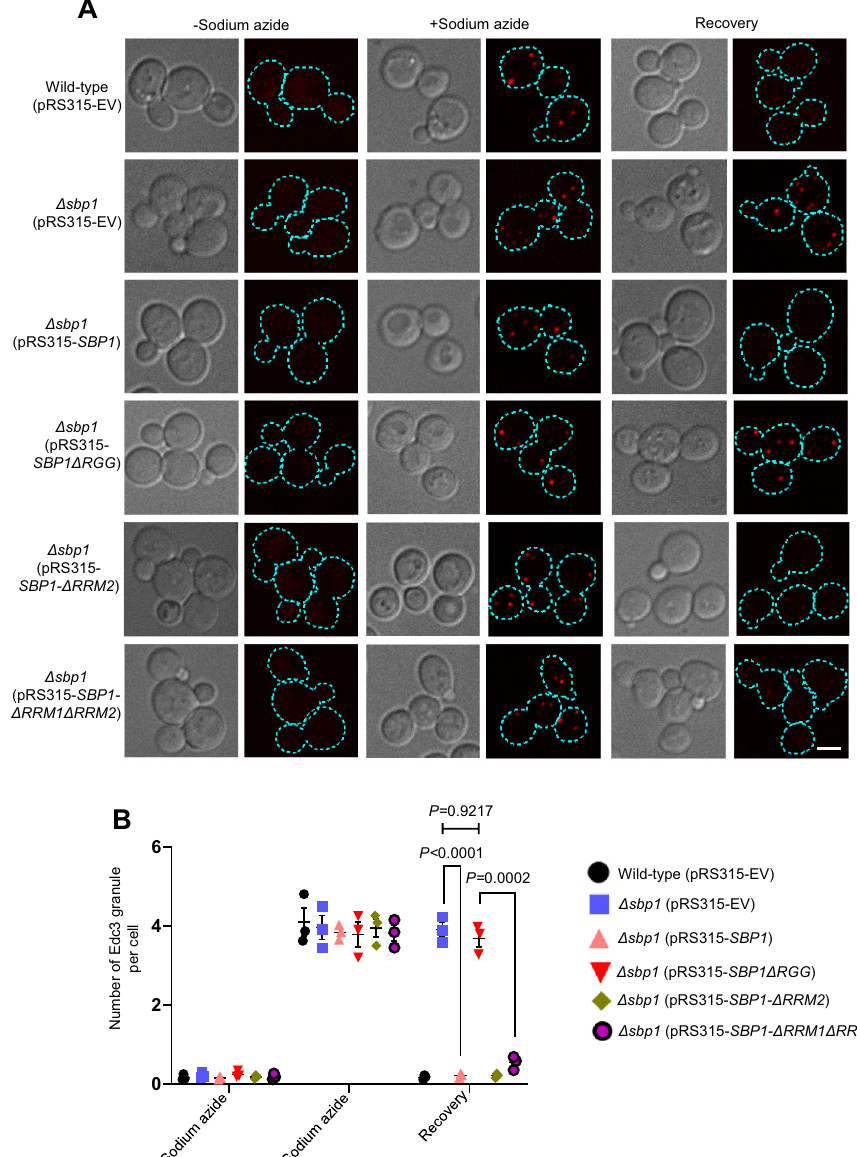
Fig. 4 RGG motif is necessary and suf fi cient to rescue P-body disassembly defect. A Live-cell microscopy to observe disassembly of PBs upon complementation with wild-type Sbp1 and mutants following sodium azide stress condition. Plasmid containing wild-type Sbp1-GFP and Sbp1 mutants were transformed in endogenously tagged Edc3-mCherry and Edc3m-Cherry Δ sbp1 cells as indicated. Cells were cultured till 0.35 – 0.4 OD 600 and incubated for 30 min with or without 0.5% (v/v) sodium azide at 30 °C. Subsequently, cells were pelleted and washed thrice with glucose-containing medium. For stress recovery, the resuspended cells were grown for an additional 1 h at 30 °C in media without sodium azide. Dotted lines in the images represent cell boundaries. Scale Bar, 3 µ m. B Quantitation of the complementation experiment as described in A . Refer to Supplementary Fig. 4 for additional complementation results. Data plots represent mean ± SEM from of n = 3, where ‘ n ’ represents number of independent experiments. A two-tailed paired student t -test was used to calculate P